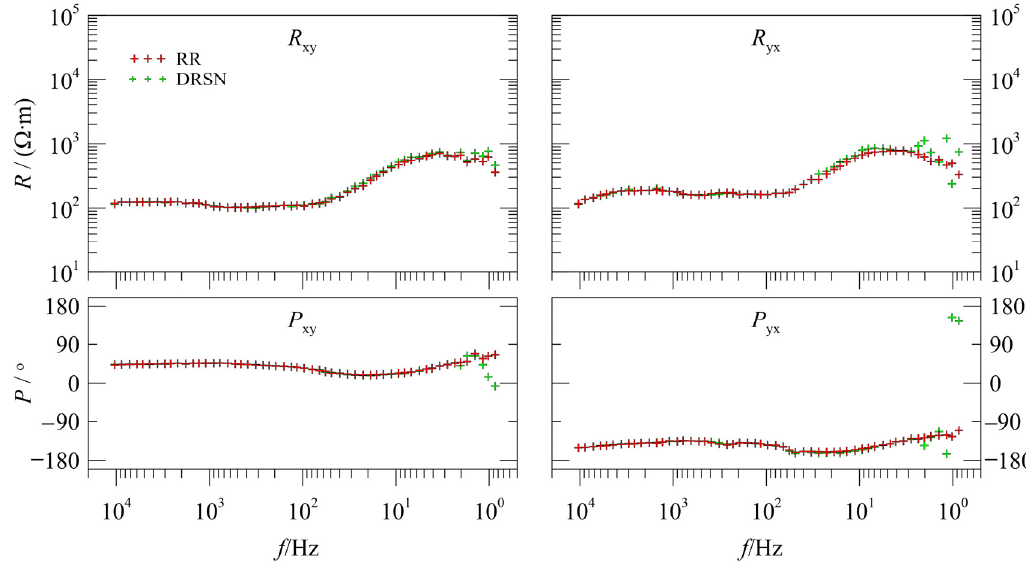
Figure 20. The apparent resistivity curves ( upper panels) and the phase curves ( bottom panels) denoised by DRSN and remote reference (RR).